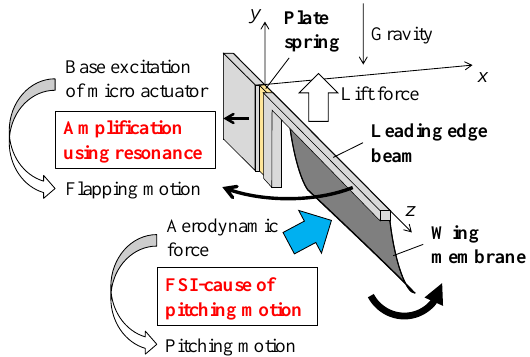
Figure 10. Flow fields on the cylindrical plane crossing the flapping wing at the time instant of 6.65 cycle when the nondi- mensional lift takes the first peak in the second half stroke: ( a ) Φ = 123°, F r = 5.1, α = 0.073; ( b ) Φ = 80°, F r = 3.3, α = 0.11. In each cylindrical plane, the color contour shows the magnitude of the vorticity in the wing’s longitudinal direction, the arrows show the fluid velocity field, and the color of each arrow shows the magnitude of the velocity.